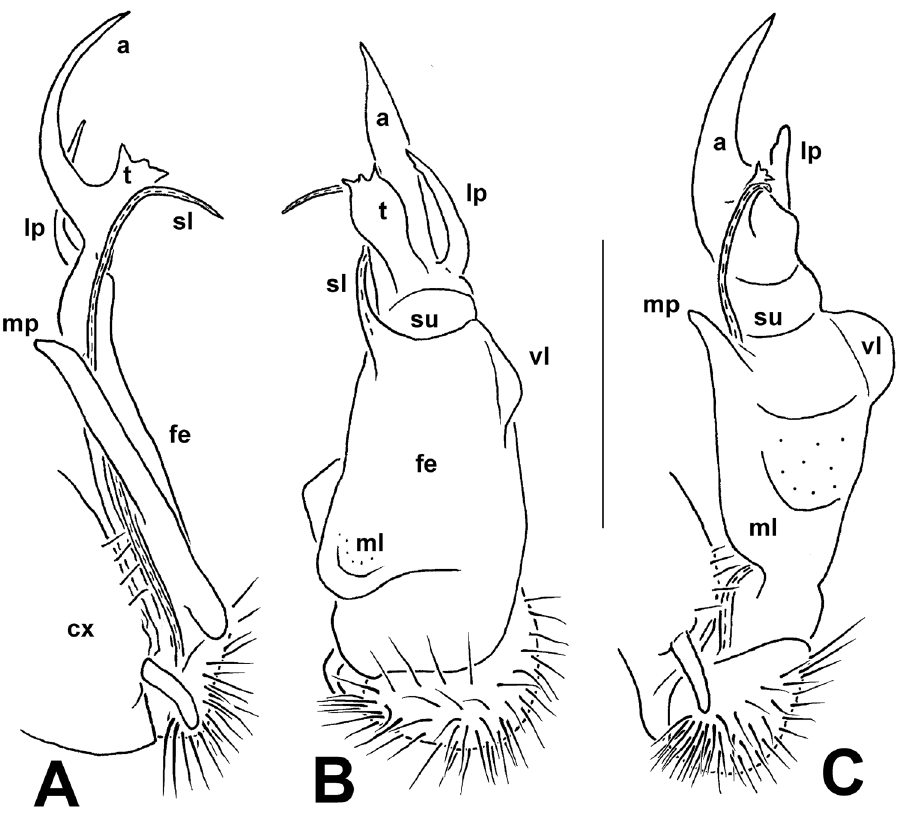
Figure 9. Annamina irinae sp. n., ♂ paratype (ZMUM), left gonopod, A dorsomesal, B ventral and C mesal views, respectively (cx = coxite; fe = femorite, vl = ventral lobe; ml = mesal lobe; su = postfemoral sulcus; lp = lateral process; mp = mesal process; a = apical process; sl = solenomere; t = solenophore tooth). Scale bar 0.5